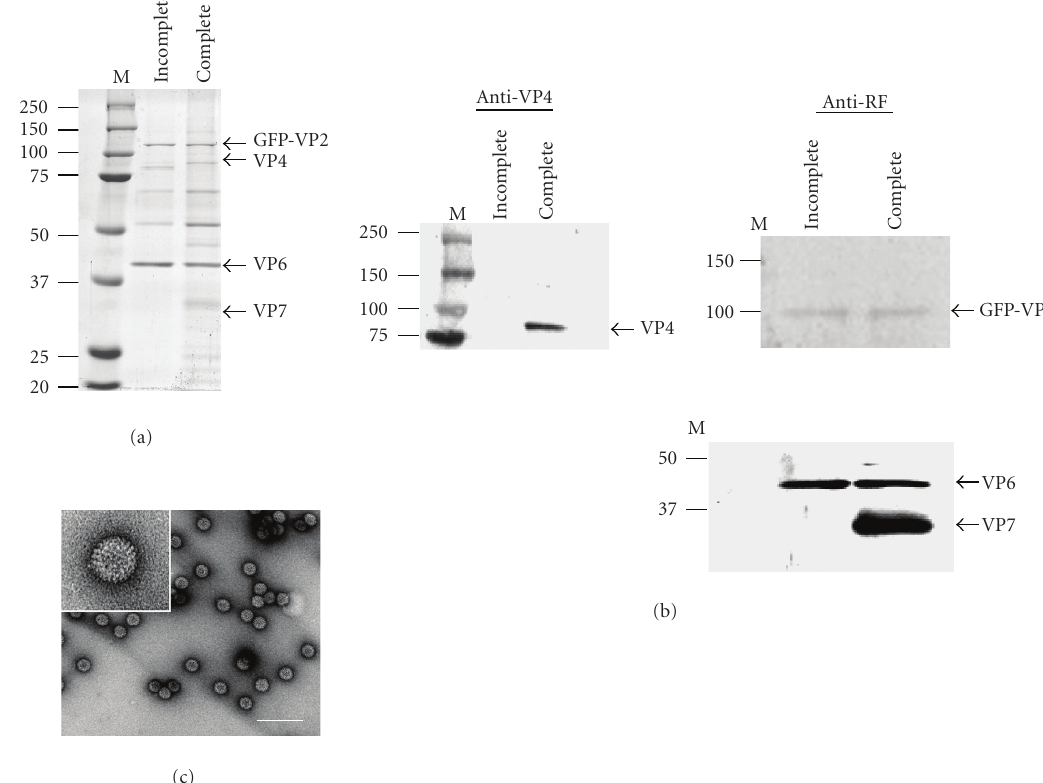
Figure 1: Analysis of VLP purified from baculoviruses infected Sf9 insect cells. Incomplete and complete VLP from the culture medium of Sf9 cells were purified using CsCl gradients. (a) Coomassie blue-stained SDS-PAGE showing incomplete and complete VLP containing GFP:VP2 fusion proteins. (b) Western-blot of recombinant VLP proteins using either anti-VP4 or anti-RF rotavirus antibodies. M: protein molecular weight markers. (c) Electron microscopy analysis of incomplete VLP negatively stained with a 2% uranyl acetate solution, scale bar 100 nm . Insert: higher magnification of a single